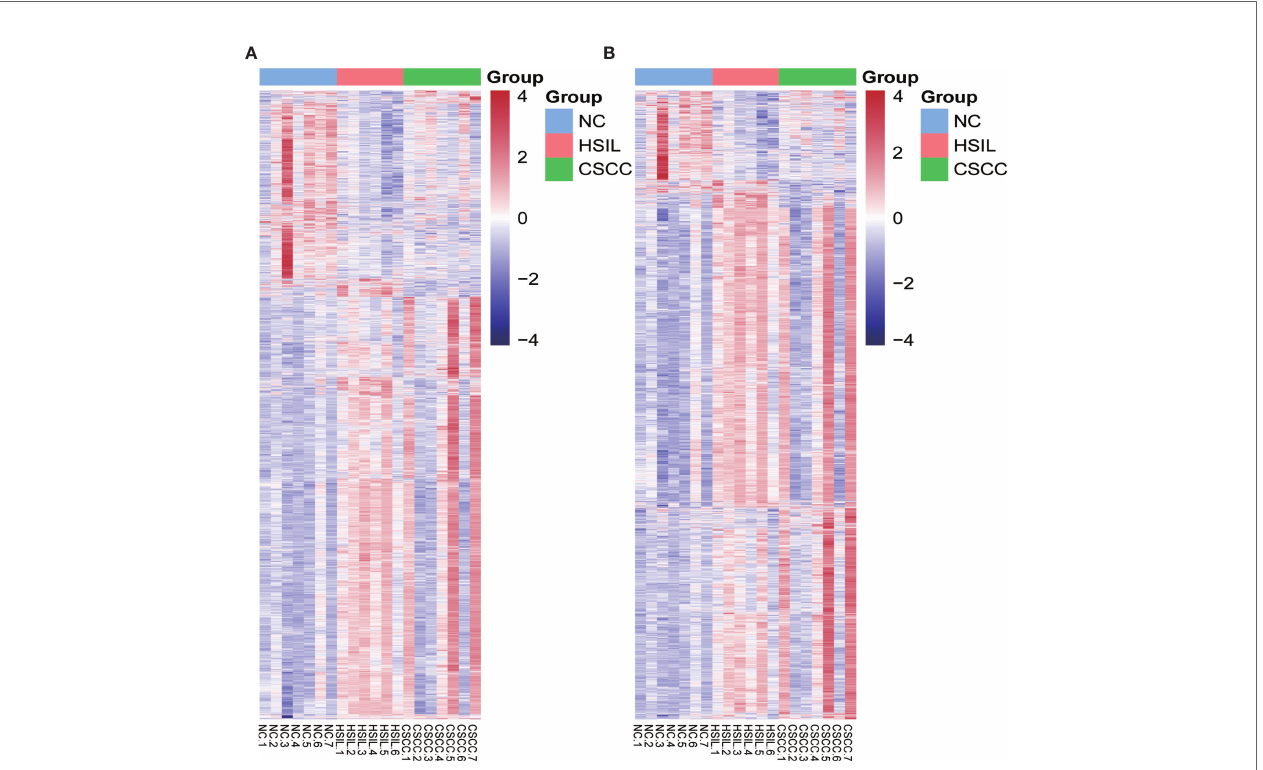
FIGURE 2 | Heatmap of differentially expressed mRNAs (DEMs) and circRNAs (DECs) in the three comparison groups. Genes and samples (rows and columns, respectively) are reordered on the basis of the normalized expression value and give rise to groups of samples and genes with similar expression patterns, according to the color key. The samples (column) were clustered into three groups according to cervical sample: seven individuals with NC, six individuals with HISL and seven individuals with CSCC. (A) DEMs; (B) DECs.